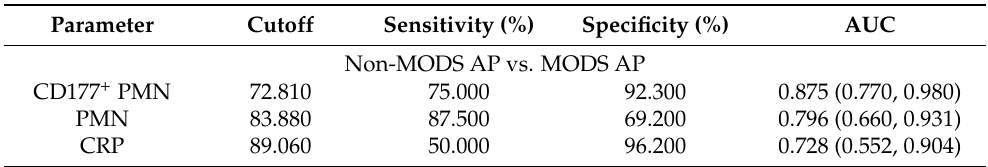
Table 2. The AUC and the clinically optimal cutoff points of CD177 + PMNs, PMNs, and CRP for predicting the severity of